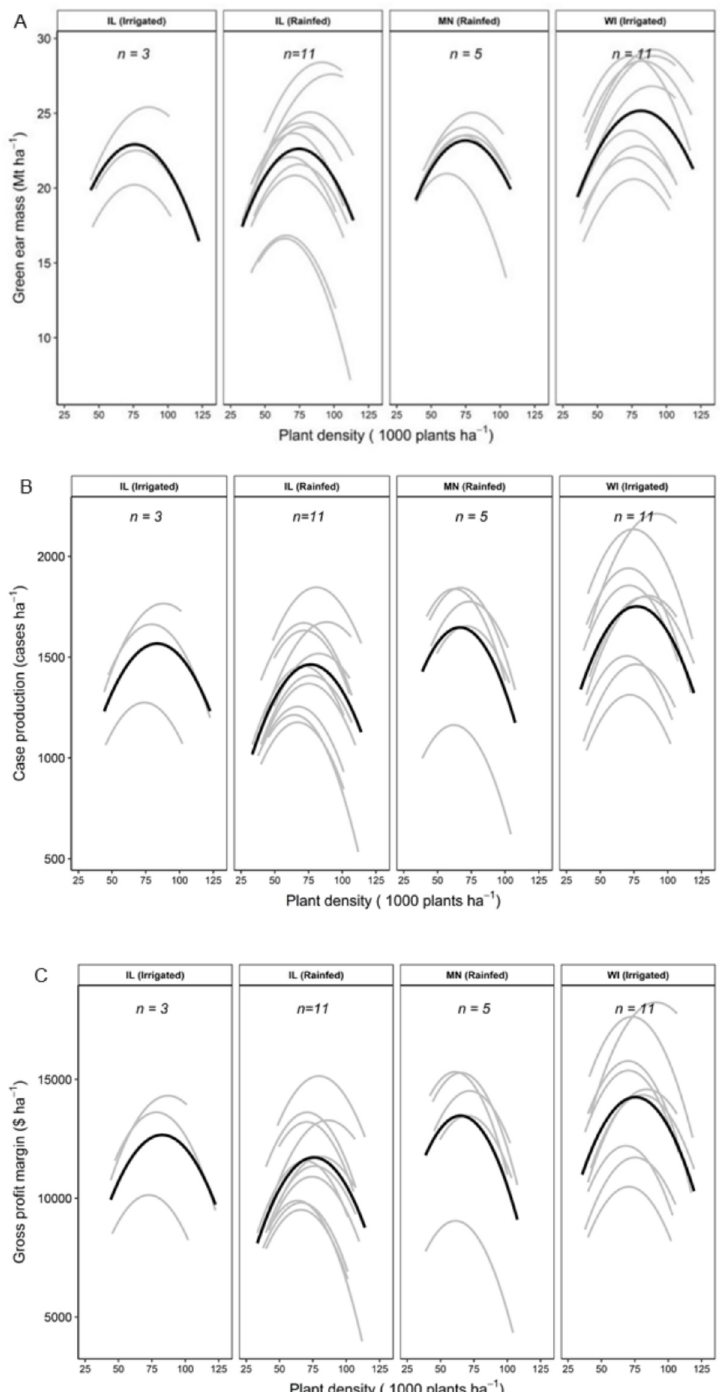
Fig 1. Linear mixed effects models of plant density effect of a crowding stress tolerant hybrid on (A) green ear mass (Mt ha -1 ), (B) case production (cases ha -1 ) and, (C) gross profit margin ($ ha -1 ) for four production areas. Thick black line is production area mean fixed effect. Grey lines are individual field relationships (best linear unbiased predictors, BLUPs), as estimated from the random effects structure.